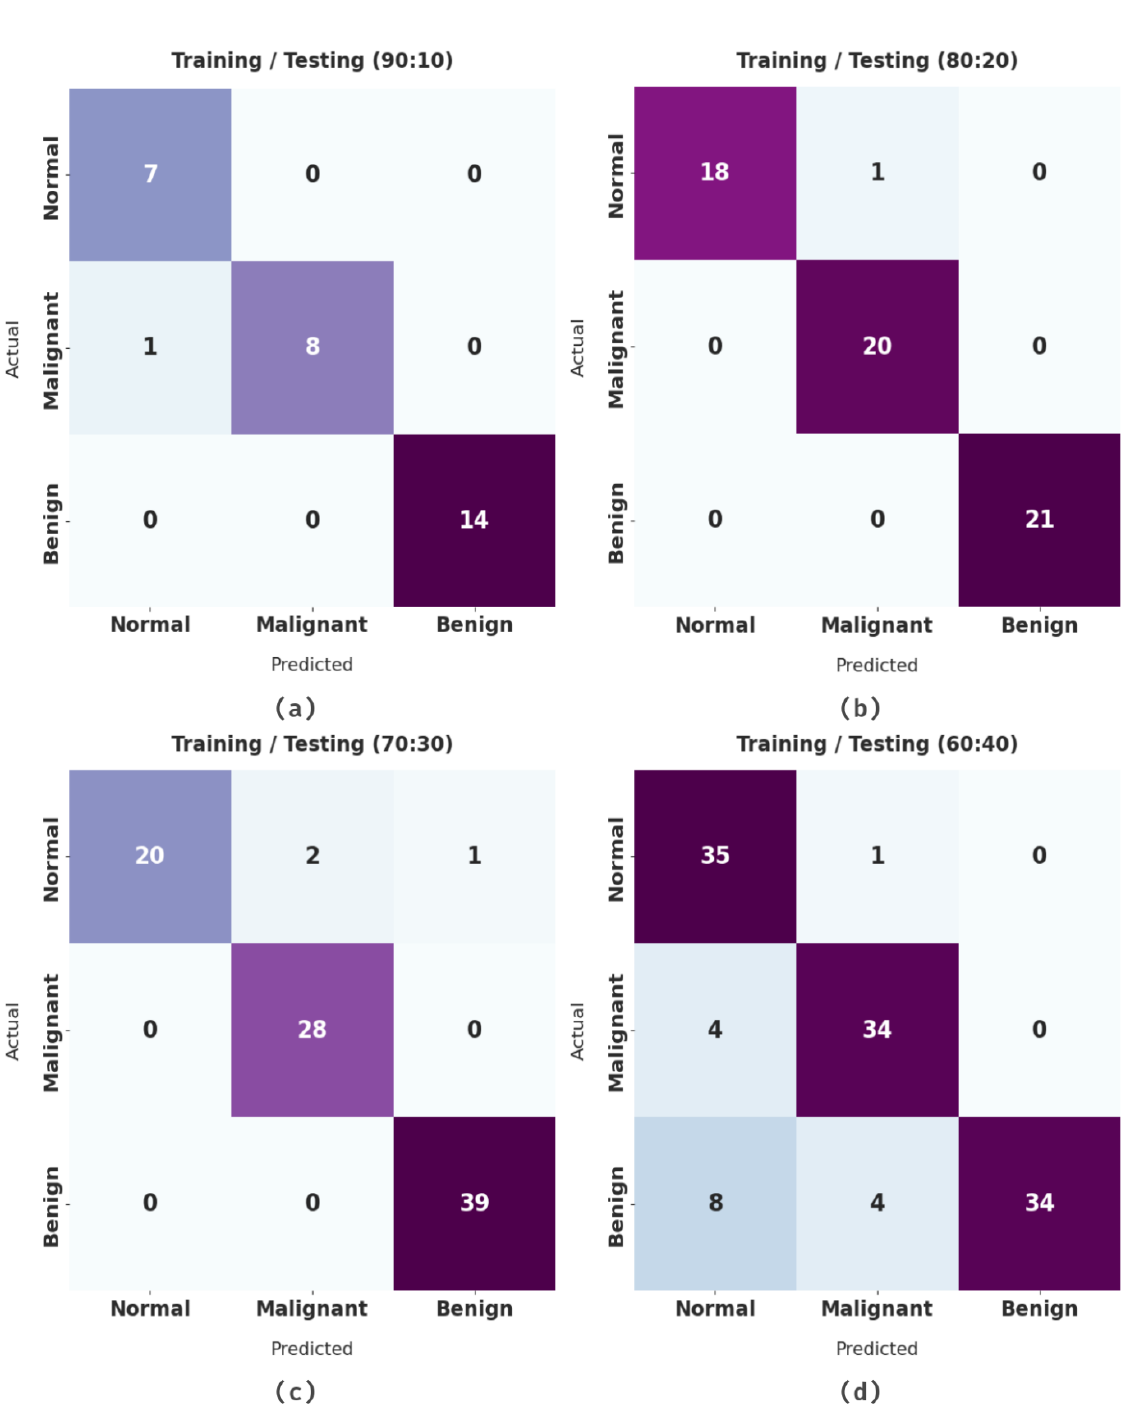
Figure 4. Confusion matrix of the CSO-CADLCC technique on distinct sizes of training/testing dataset. ( a ) TR/TS data of 90:10, ( b ) TR/TS data of 80:20, ( c ) TR/TS data of 70:30, and ( d ) TR/TS data of 60:40